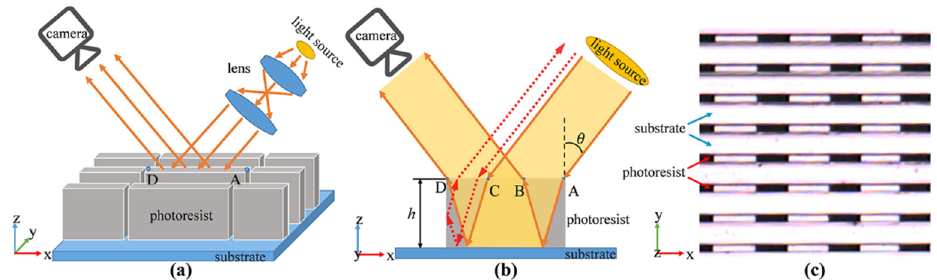
Figure 1. ( a ) Schematic diagram of the optical detection system; ( b ) schematic diagram of light propagation in photoresist structure; ( c ) image of the microstructures observed by the optical detection method.